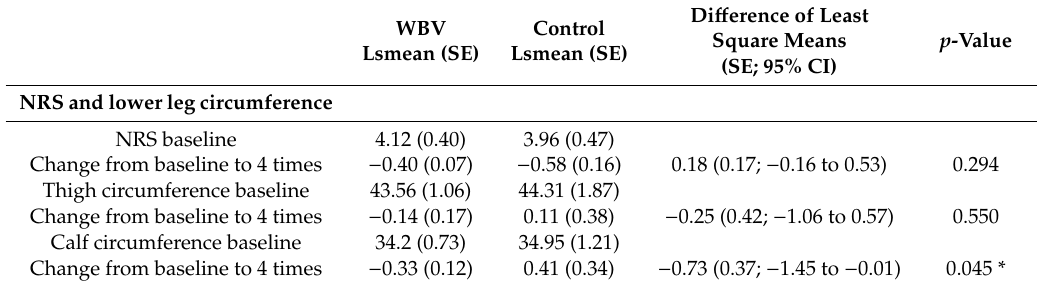
Table 3. Changes in mean difference between baseline and follow-up assessment of all outcome